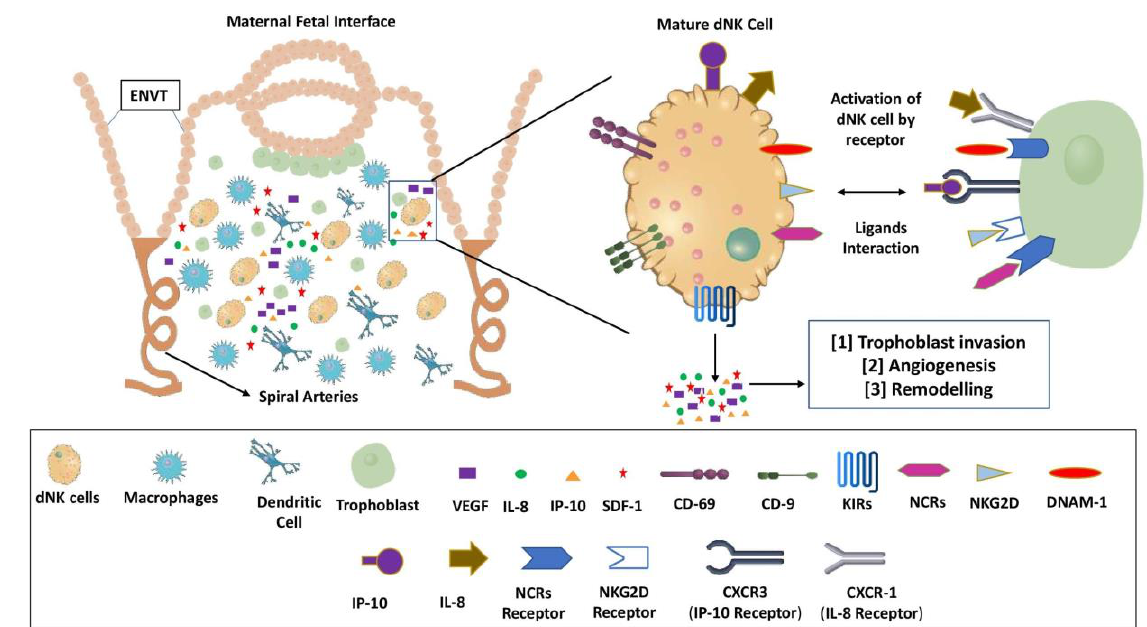
Figure 2. Interaction of trophoblast and decidual NK (dNK) cells at the maternal-fetal border. The interactions between the trophoblast and dNK cells are mediated by multiple interactions of receptor ligands at the interface between the mother and the fetus. This leads to activation of dNK cells, and the activated dNK cells release the cytokines and chemokines that play vital role placental development by mediating trophoblast invasion, angiogenesis and remodeling of placental tissues/spiral arteries. VEGF: Vascular endothelial growth factor; IL-8: Interleukin-8; IP-10: Interferon inducible protein-10; SDF-1: Stromal cell derived factor-1; CD-69: Cluster of Differentiation-69; CD-9: Cluster of Differentiaton-9; KIRs: Killer Ig-like receptors; NCRs: Natural cytotoxicity receptors; NKG2D: Natural killer group 2D; DNAM-1: DNAX accessory molecule.